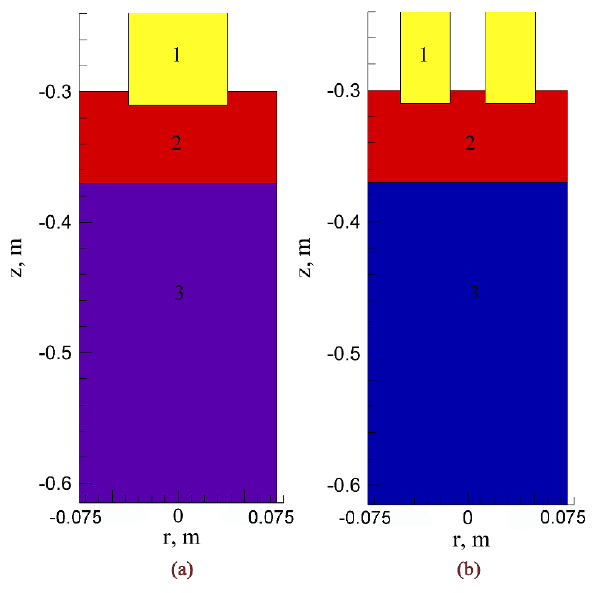
Figure 2. Computational domains. ( a ) OE-ESR. ( b ) TSCE-ESR. 1-electrode, 2-slag pool,